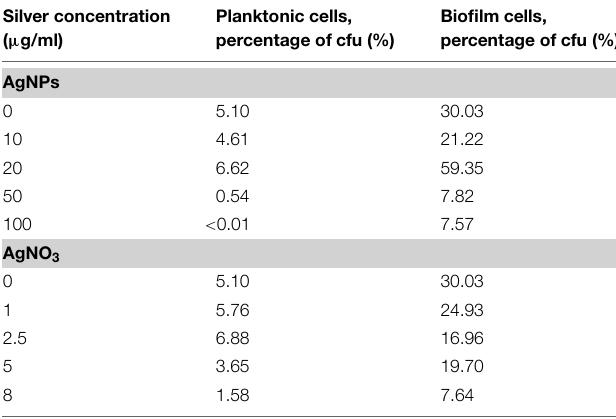
TABLE 1 | Effect of silver nanoparticles (AgNPs) and silver nitrate (AgNO 3 ) on the proportion of cfu to total cell counts of planktonic cells and biofilm cells of P. aeruginosa after growth for 24 h at 36 ◦ C in LB medium.